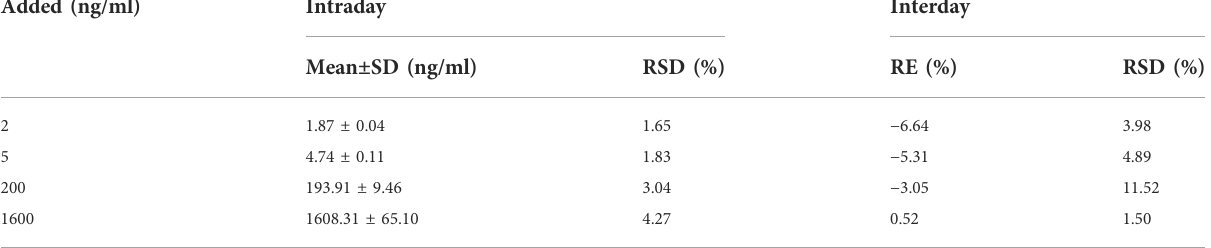
TABLE 1 Intraday and interday precision and accuracy for glytrexate in rat plasma ( n = 6). Added (ng/ml)